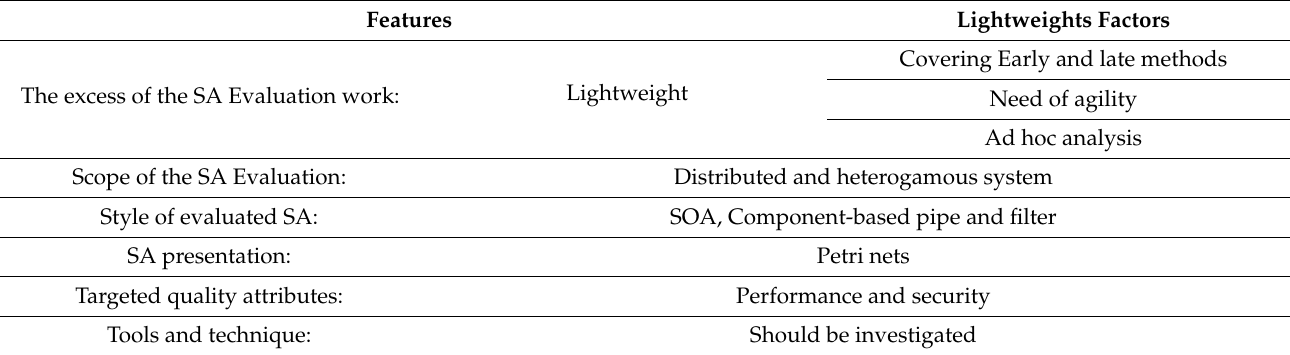
Table 6. The identified features and lightweight’s